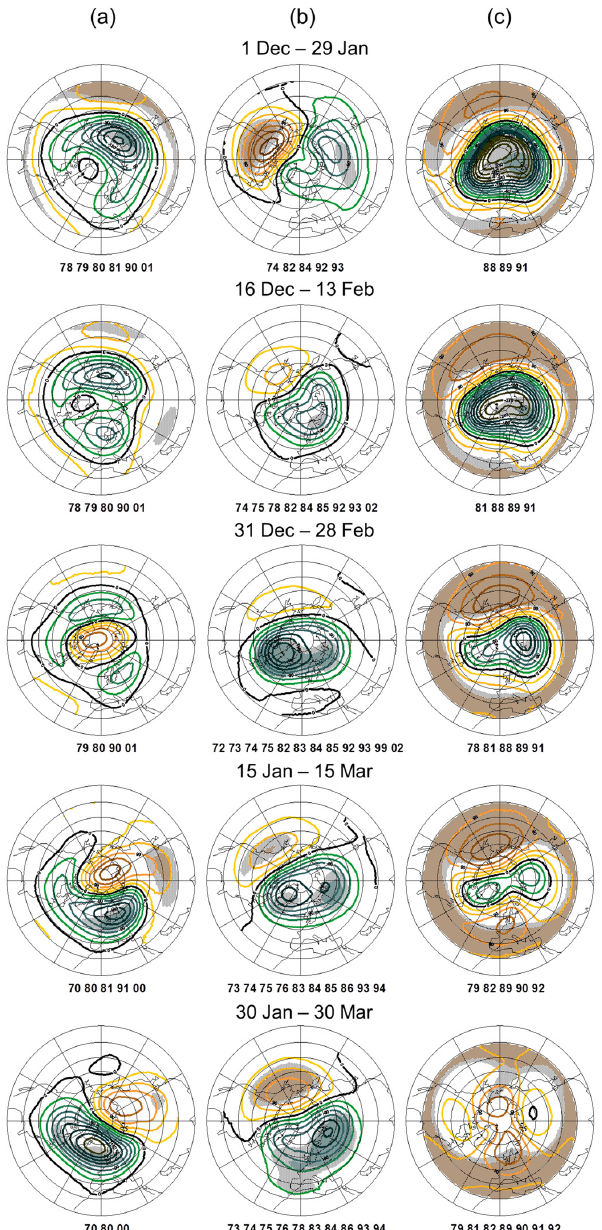
Fig. 3. Stratosphere in the years 1970–2002. As in Fig. 1, but for (a) situations, in which the effect of the geomagnetic activity was decreased ( R ≥ 100; 6 Kp < 20), (b) situations, in which the effect of solar activity was decreased ( R < 100; 6 Kp ≥ 20), (c) situations, in which, together with high solar activity, also high geomagnetic activity ( R ≥ 100; 6 Kp ≥ 20) was observed.